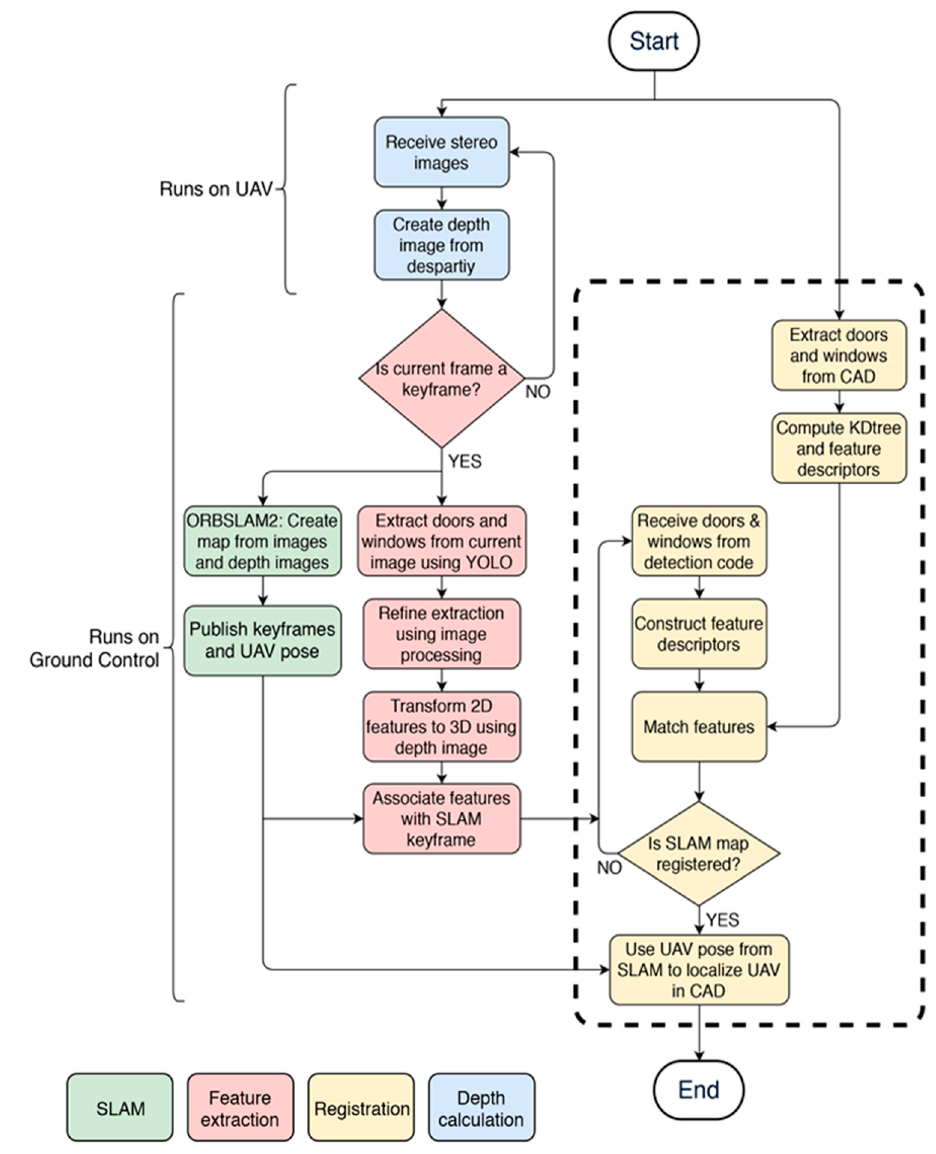
Figure 10. Pipeline process flow.